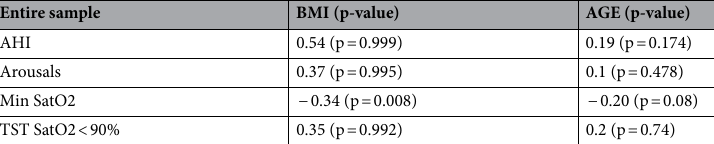
Entire sample BMI (p-value) AGE (p-value) AHI 0.54 (p = 0.999) Min SatO2